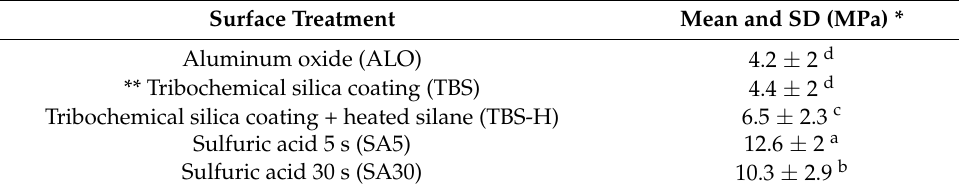
Table 3. SBS results. Mean and standard deviation (SD) of the shear bond strength (MPa).